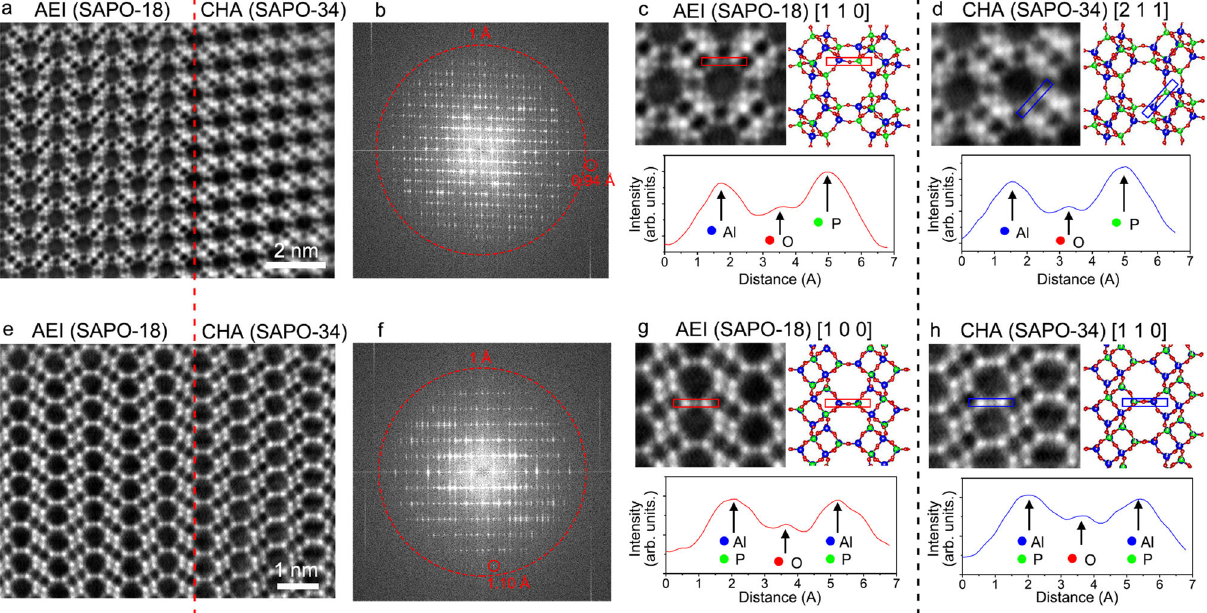
Fig. 2 Atomic imaging of SAPO-34 and SAPO-18 lattices. a iDPC-STEM image of SAPO-34 and SAPO-18 lattices from the AEI [1 1 0] projection. b FFT pattern of a showing an information transfer of 0.94 Å. c , d Magni fi ed images and intensity pro fi les of SAPO-18 ( c ) and SAPO-34 ( d ) in ( a ), where the Al, O, and P atoms can be clearly identi fi ed. e iDPC-STEM image of SAPO-34 and SAPO-18 lattices from the AEI [1 0 0] projection. f FFT pattern of ( e ) showing an information transfer of 1.10 Å. g , h Magni fi ed images and intensity pro fi les of SAPO-18 ( g ) and SAPO-34 ( h ) in ( e